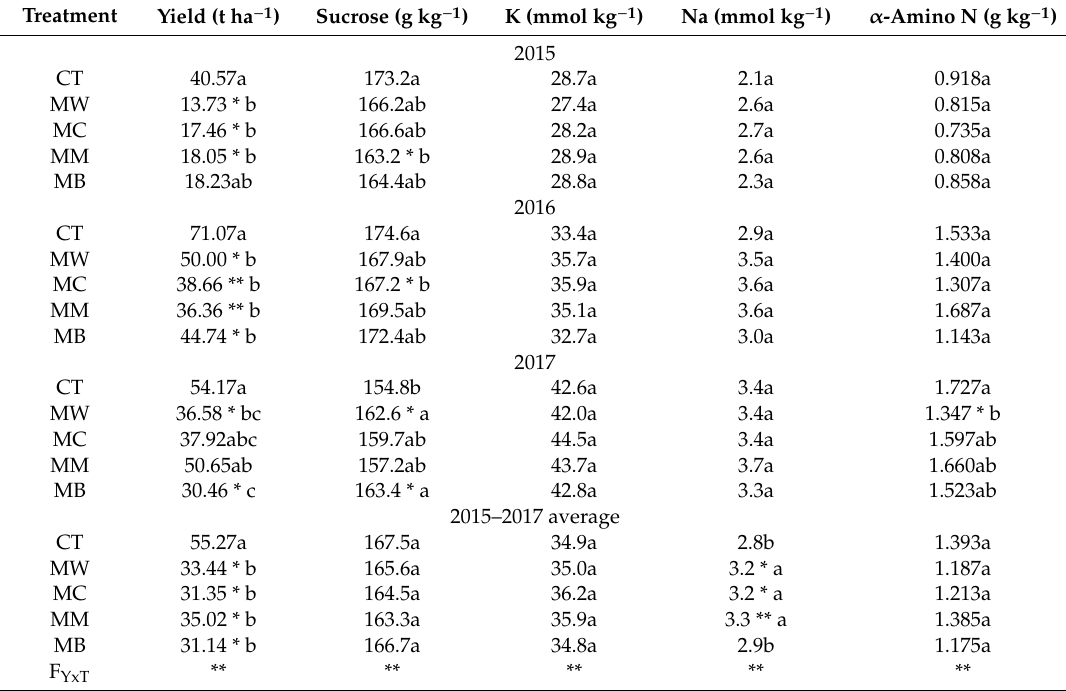
Table 5. The e ff ect of intercropping on the yield and the chemical content of sugar beet